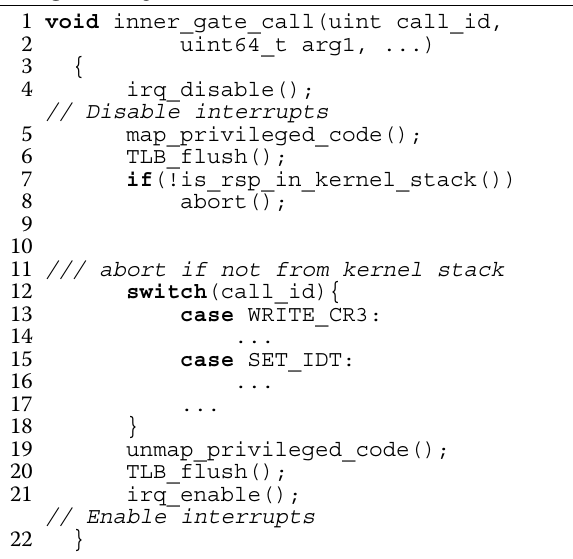
to each application thread. The protected stack is set as same as kernel data. When MPK Gate is called, the thread will switch to the protected stack to ensure control flow